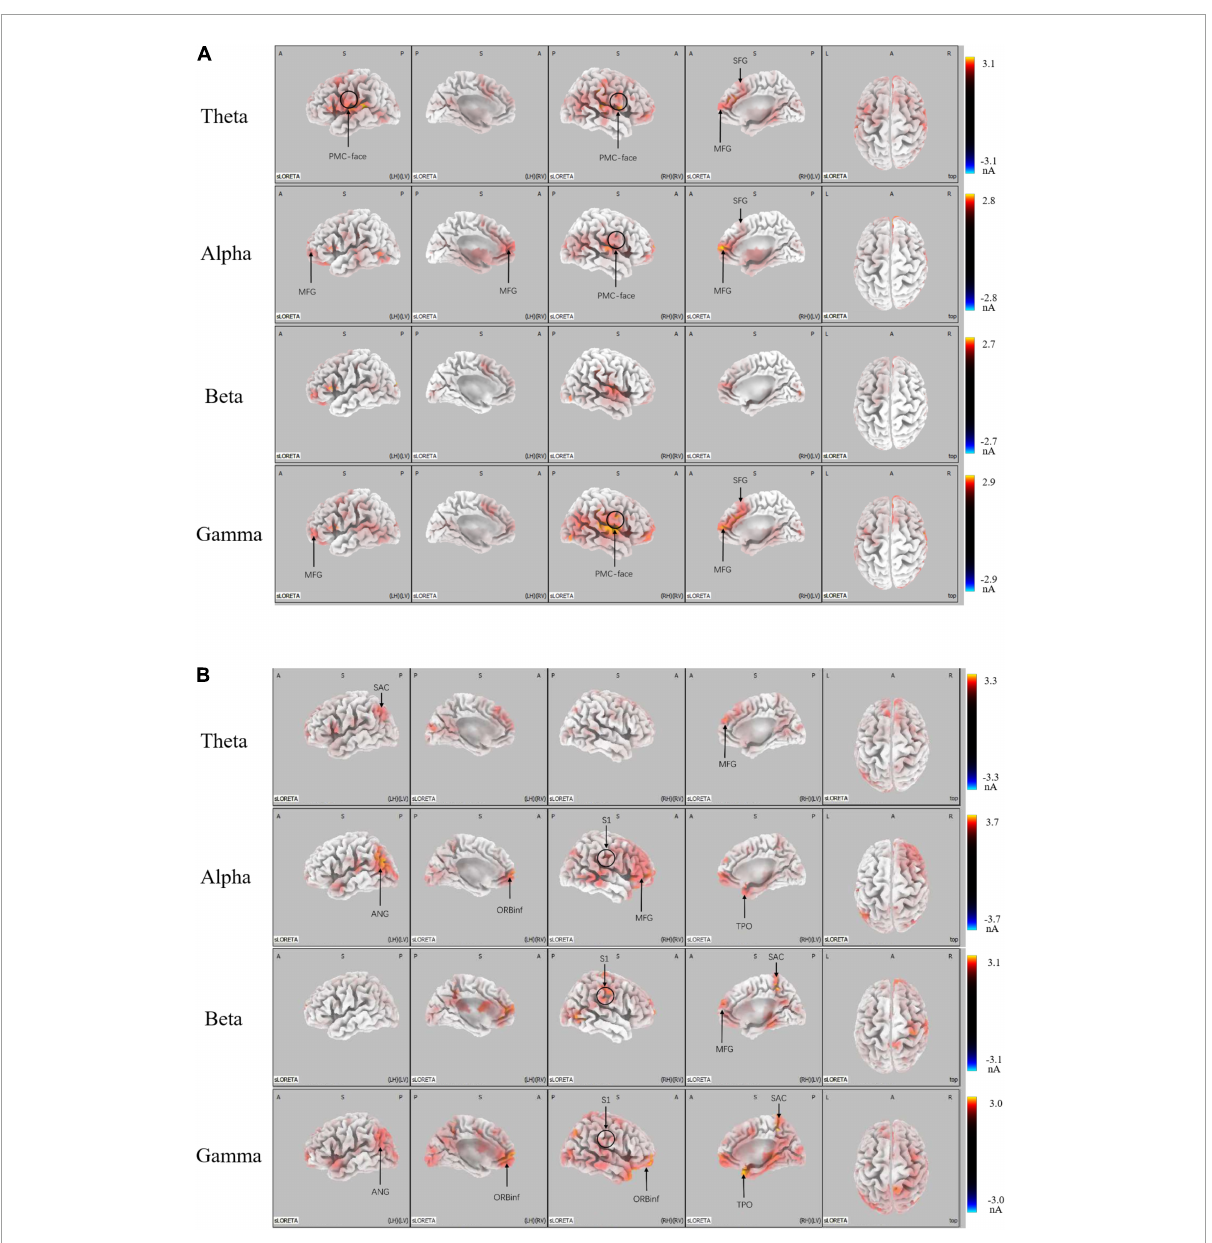
FIGURE4 LORETA probabilistic map showing cortical activation and a significant difference between micro-expression minus macro-expression in (A) Positive emotion and (B) Negative emotion (Micro-expression minus Macro-expression) (B) Negative emotion (Macro-expression minus Micro-expression). Red colors represent a greater activation, blue colors represent a less activation.